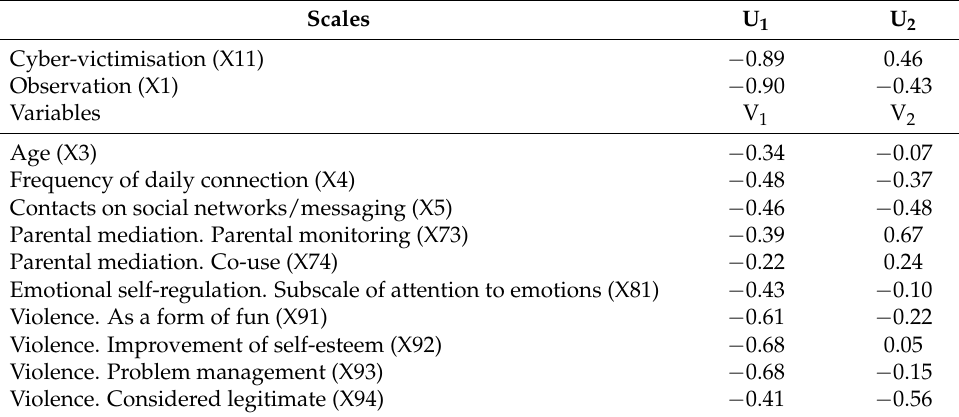
Table 6. Correlations between original and canonical variables.